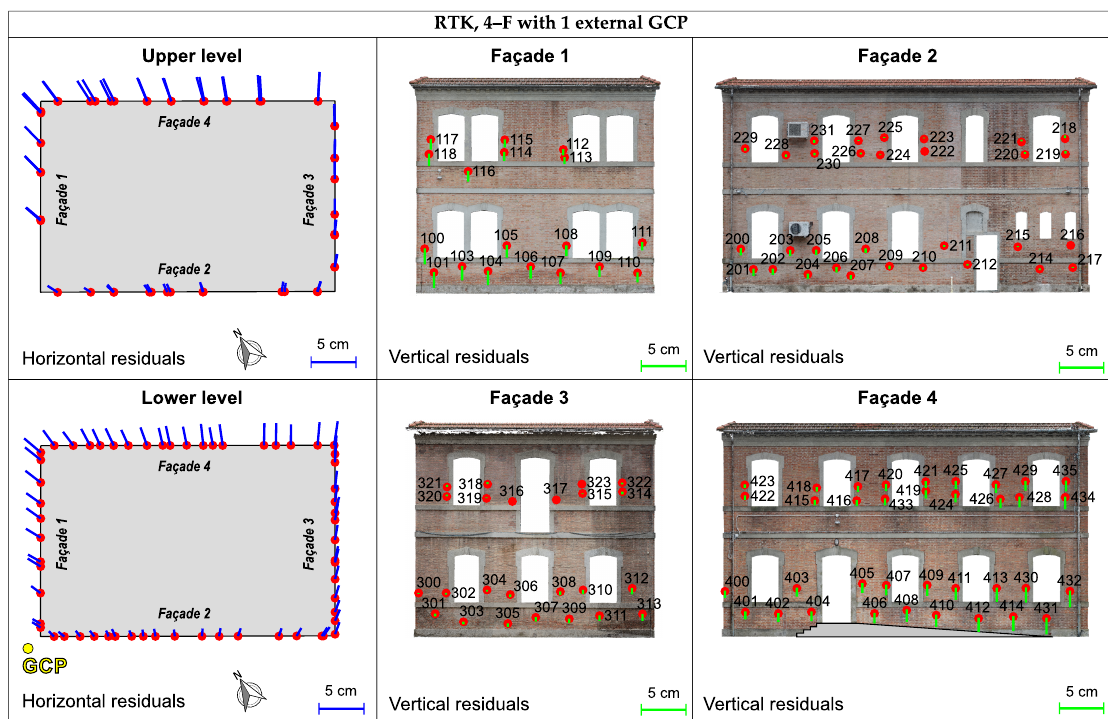
Figure A5. Horizontal and vertical residuals for RTK image dataset processed as an overall block (4–F) with the introduction of an external GCP (shown in